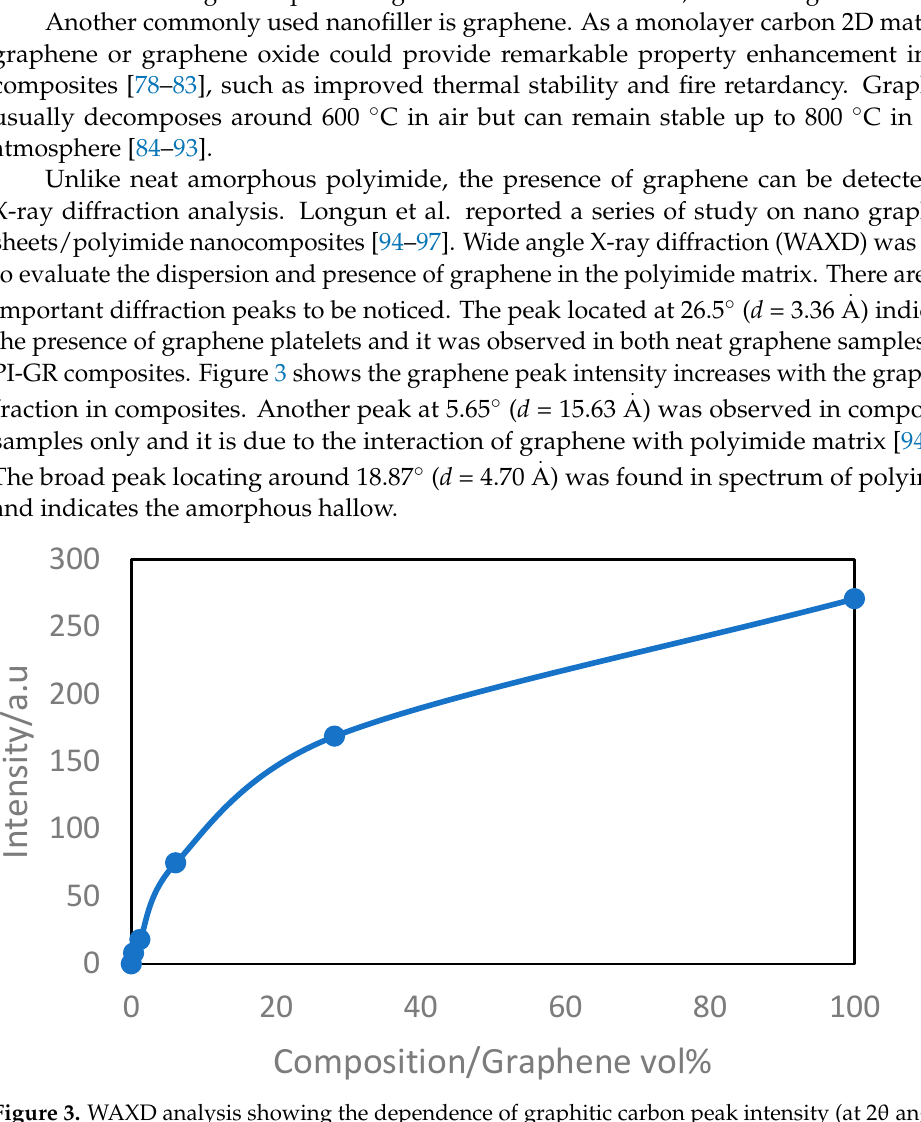
Figure 3. WAXD analysis showing the dependence of graphitic carbon peak intensity (at 2 θ angle of . 26.5 ◦ ( d = 3.36 A) for graphene/PI composites, on the weight fraction of graphene [94–97].